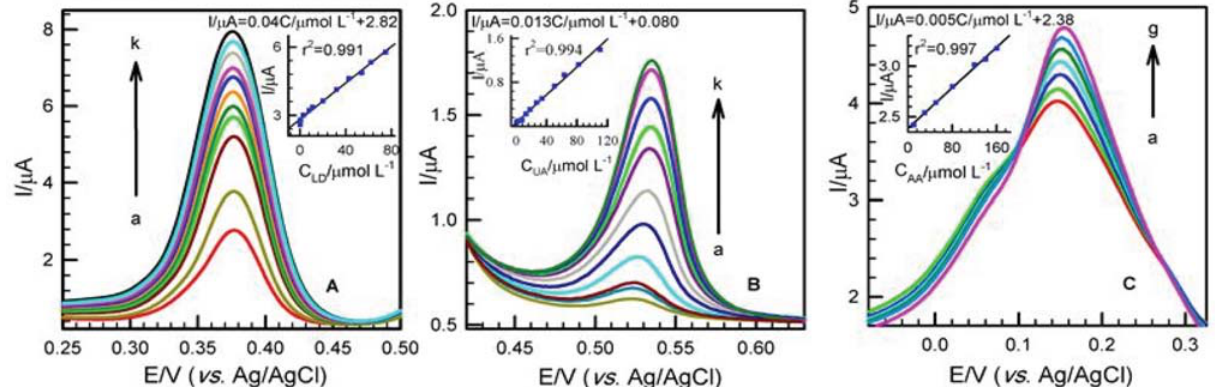
Figure 6. Differential pulse voltammograms of LD (A), UA (B), and AA (C) at PDB/MWCNTs-GCE in 0.11 mol L –1 PBS (pH 3). LD concentra- tions: (a) 0.09, (b) 0.4, (c) 3, (d) 8, (e) 11, (f) 20, (g) 32, (h) 43, (i) 54, (j) 62, (k) 75μmol L –1 ; UA concentrations: (a) 0.3, (b) 2.5, (c) 7, (d) 12.5, (e) 18, (f) 26.5, (g) 33.5, (h) 50, (i) 63, (j) 82, (k) 110 μmol L –1 and AA concentrations: (a) 10, (b) 30, (c) 50, (d) 80, (e) 120, (f) 140, (g) 160 μmol L –1 . Insets show the calibration lines from the DPVs shown in (A), (B) and